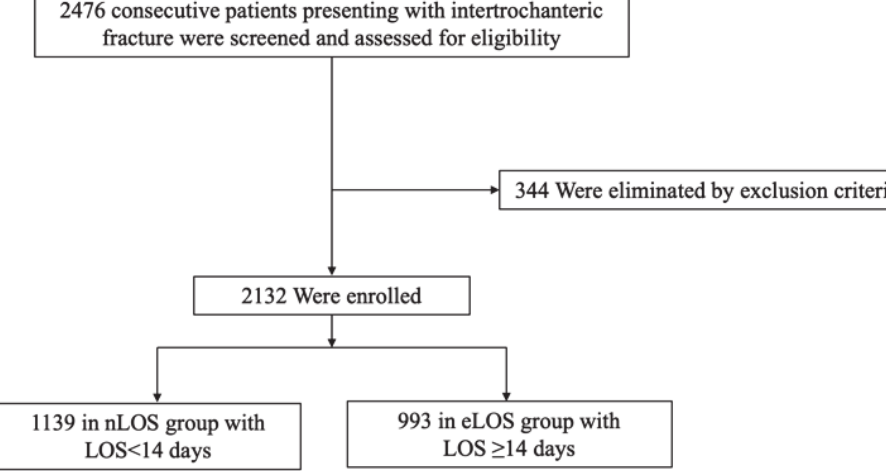
Figure 1. Flow diagram of the included patients. The comparisons of the patient characteristics and hospital outcomes in the two groups were presented in Table 1. Univariate analyses showed statistically significant differences between the eLOS group and the nLOS groups (all p < 0.10) in 11 variables, which were entered as covariates in the multivariate analysis model. When combined with clinical experience, gender, age, and age group were forced into the model, although not significant. The model thereafter inferred that obesity (with BMI ≥ 28), living in urban areas, time from injury to surgery, mECM, admission in autumn and winter, and pulmonary complications were found to be significantly associated with eLOS. In terms of other dummy variables of BMI and admitted season, the effect sizes of overweight and admitted in spring were small and nonsignificant. On the whole, patients with high mECM grades had the